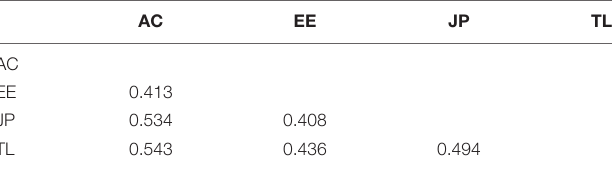
TABLE 3 | Heterotrait-monotrait (HTMT)